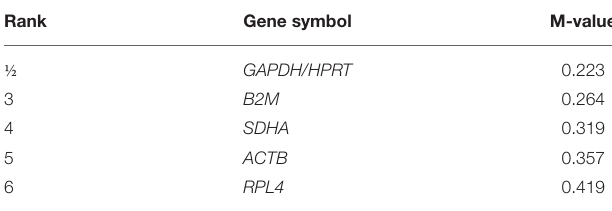
M-value, average pair-wise variation of each gene against all others.